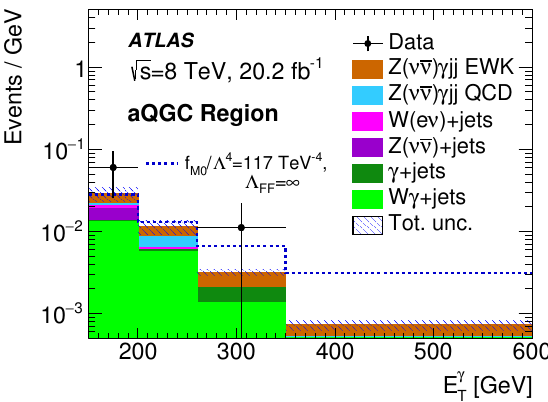
Figure 9 . Distributions of the photon transverse energy for the neutrino channel in the aQGC region, for the data (black points), and for the signal process and various background components (coloured templates). The sum of the signal prediction with one non-zero aQGC parameter and the various backgrounds discussed in the text is also shown (blue dashed line). The hatched blue band shows the systematic and statistical uncertainty added in quadrature (\Tot. unc.") in the signal and background prediction, while the error bars on the data points represent the statistical uncertainty of the data set. The number of events in each bin is divided by the bin width. The last bin also includes events beyond the range